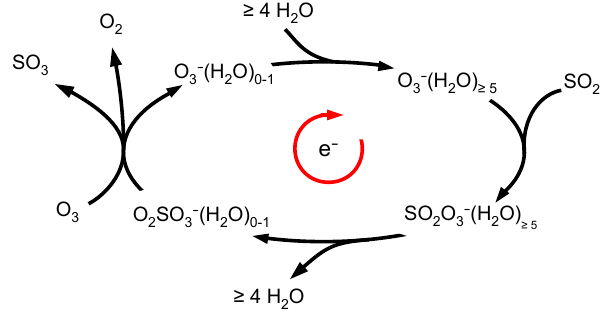
Fig. 1. Schematic of a simple catalytic SO 2 oxidation cycle. The net reaction is O 3 + SO 2 → O 2 + SO 3 , and the catalyst is the electron. All reaction rates are mainly